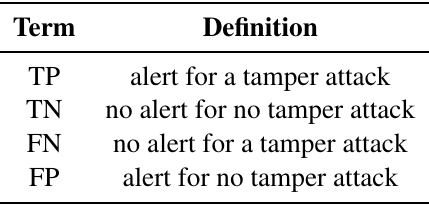
Table 3. Classification of the detection